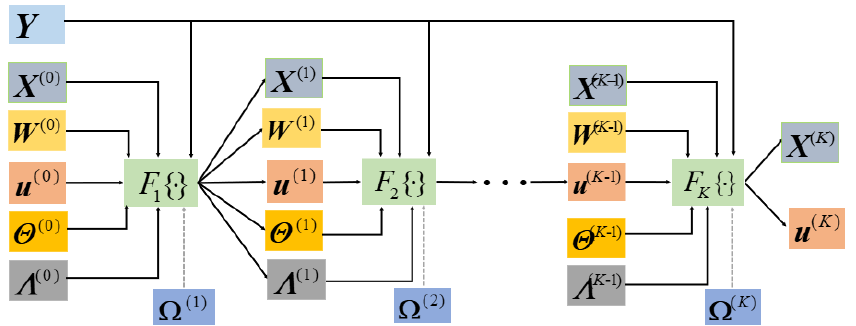
Figure 2. The network structure of ANM-ADMM-Net.